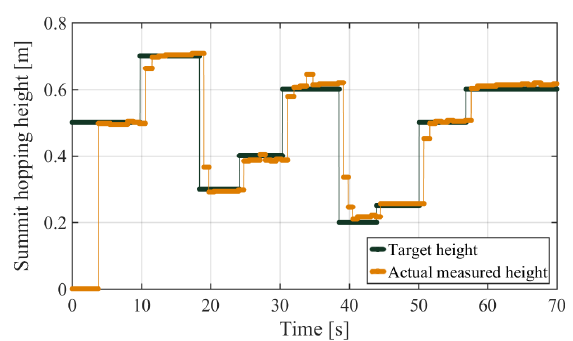
Figure 13. Summit hopping height during continuous hopping to different